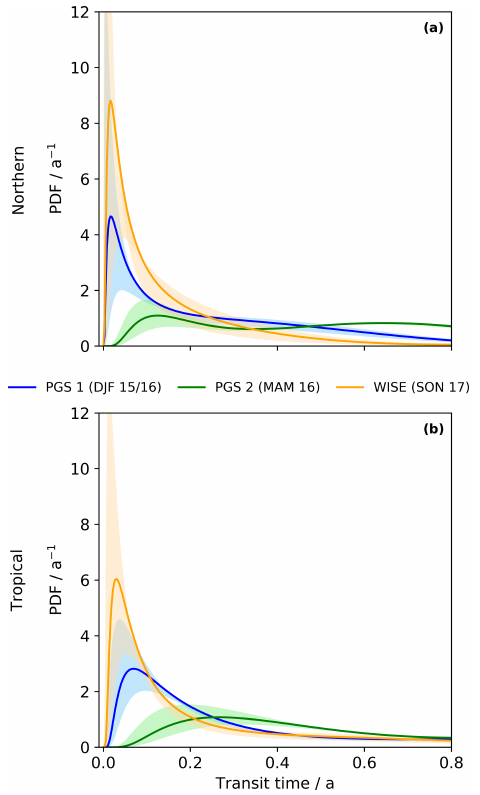
Figure 7. Campaign-averaged age spectra for PGS phase 1 (blue), PGS phase 2 (green), and WISE (orange). Panel (a) shows normal- ized inverse age spectra G N referring to the northern hemispheric tropopause section, while (b) shows normalized inverse age spectra G T referring to the tropical tropopause section. Colored shadings give the uncertainty range of the spectra derived from the Monte Carlo simulation (see Sect. 2.2.4 for details).